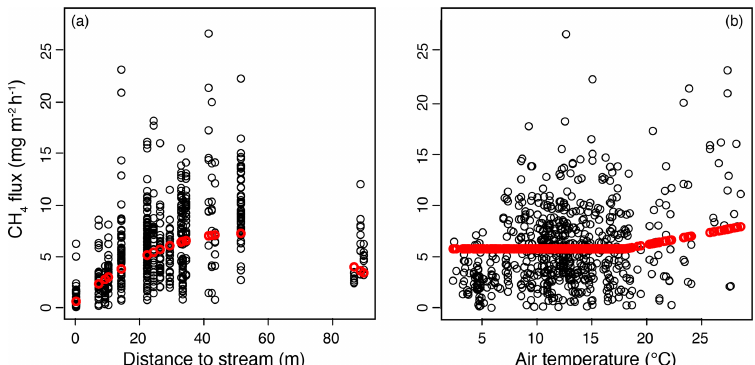
Figure 5. Results of the mixed-effect model constructed to examine the spatial variation in methane (CH 4 ) fluxes in the valley fen using a 3-year dataset. Response curves (in red) of CH 4 flux to (a) distance to stream, with the air temperature kept constant at 18 ◦ C, and (b) air temperature, with the distance to stream kept constant at 27m (mean value of the